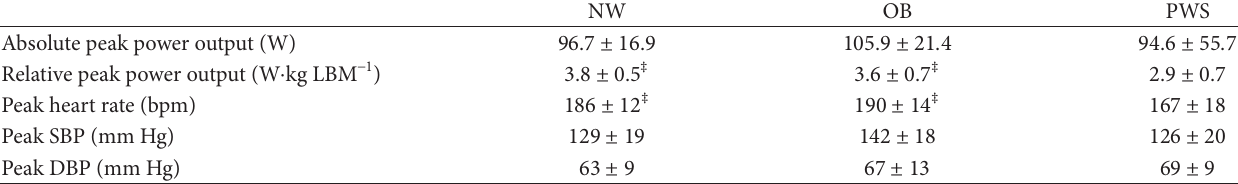
Table 2: Responses to peak intensity exercise, presented as mean ± SD.